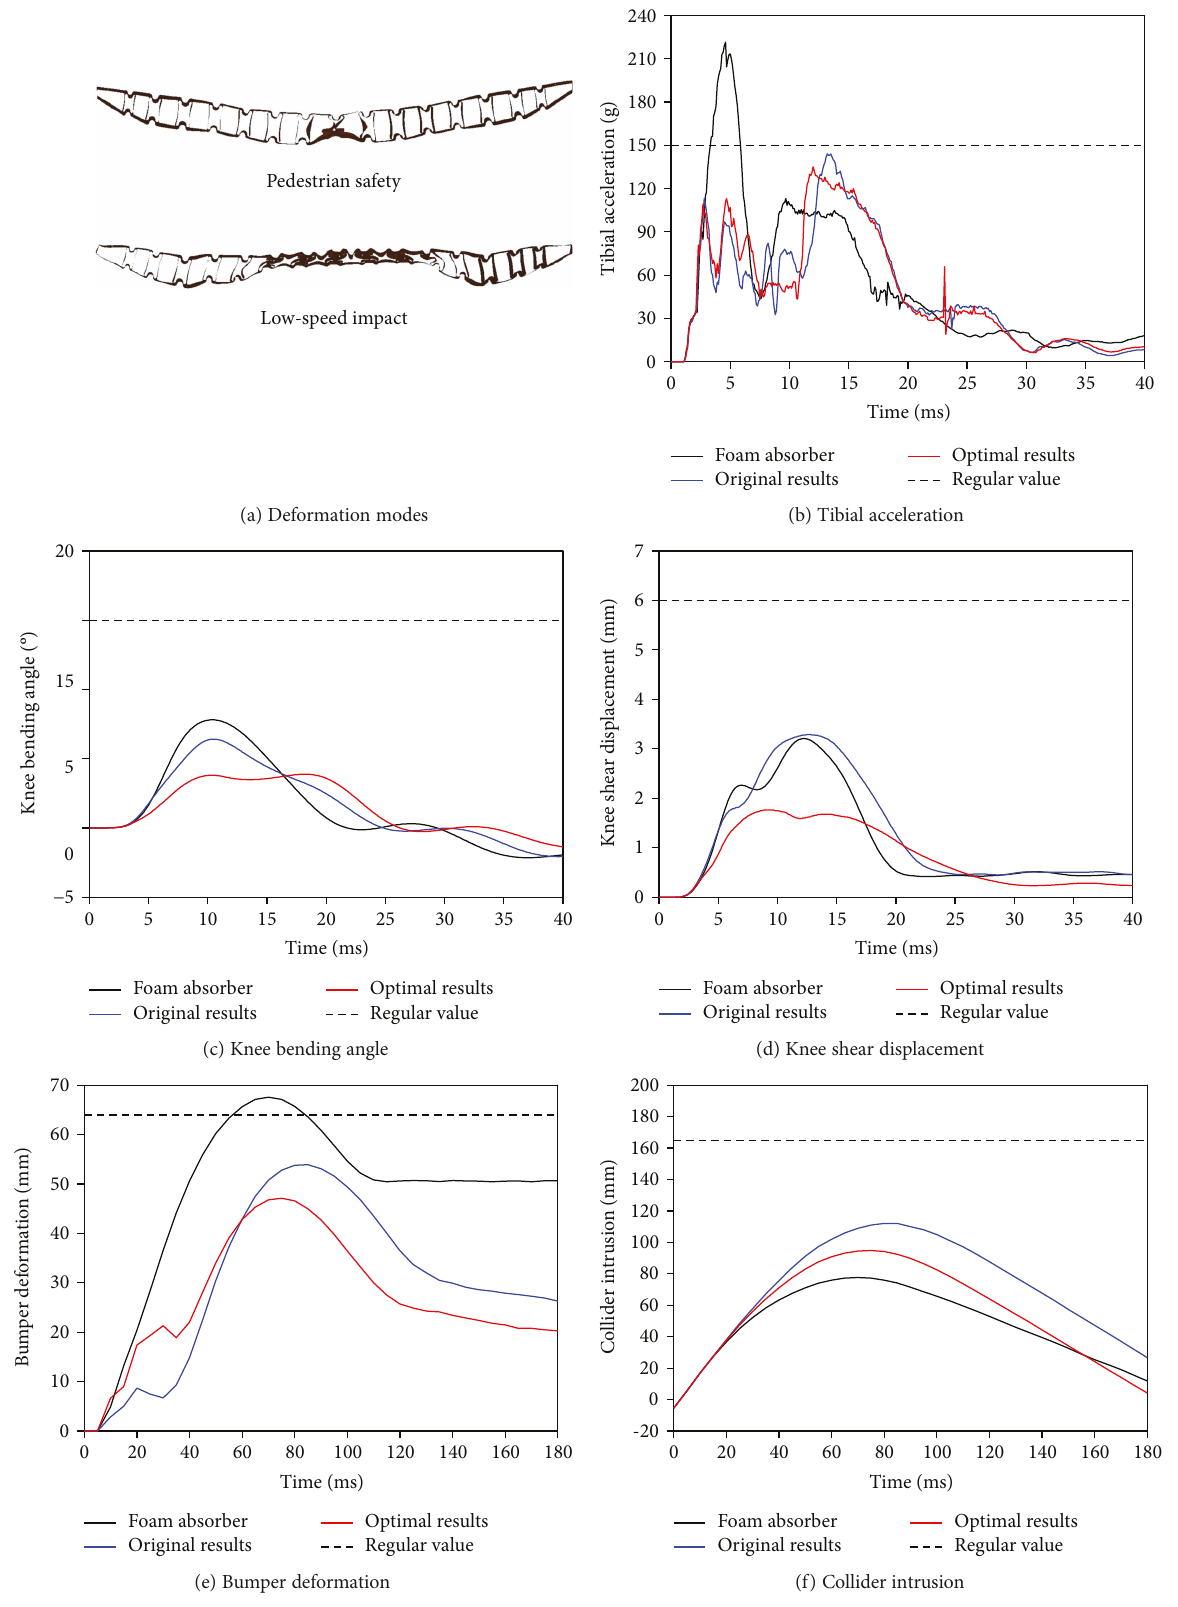
Figure 6: Comparison of evaluation index values regarding pedestrian safety and low-speed